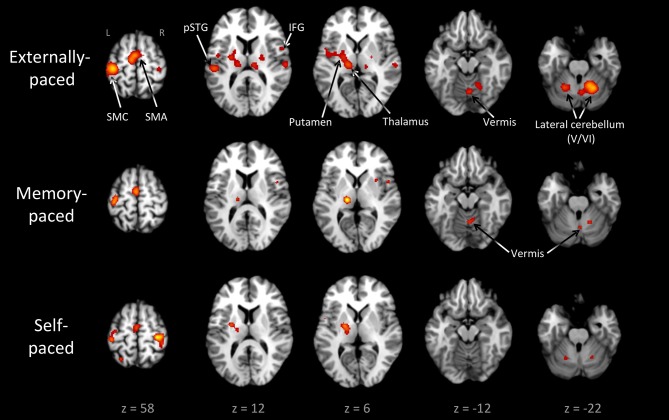
Individual ALE maps for the three types of pacing studied. The analyses are p < 0.01, FDR corrected. The slices are shown in neurological convention. Abbreviations: IFG, inferior frontal gyrus; L, left; pSTG, posterior superior temporal gyrus; R, right; SMA, supplementary motor area; SMC, sensorimotor cortex.